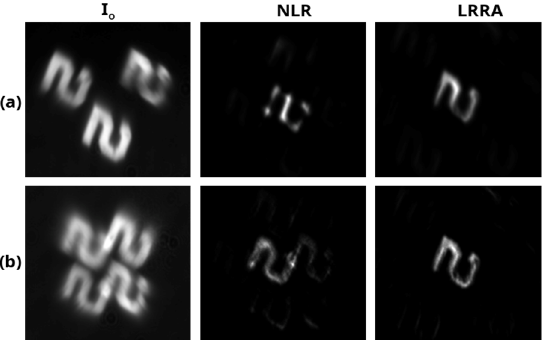
Figure 10. Images of the I O of the test object, synthesized PSF and the reconstruction results using NLR and LRRA. ( a , b ) corresponds to the three and four aperture LADISA, respectively. NLR and LRRA. ( a , b ) corresponds to the three and four aperture LADISA,